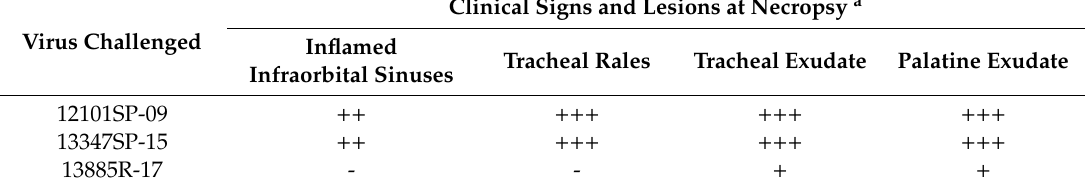
Table 3. Clinical signs and lesions at necropsy recorded six days post inoculation (p.i.) in chicks vaccinated with 4 / 91 and challenged with three di ff erent IBV isolates from di ff erent years. Clinical Signs and Lesions at Necropsy a Virus Challenged Inflamed